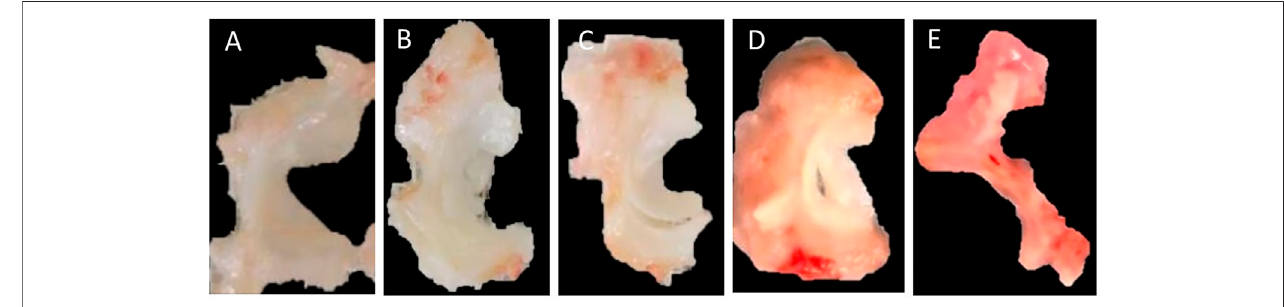
FIGURE 2 | Morphological scoring of the meniscus. (A) 0 = normal, (B) 1 = surface fi brillation, (C) 2 = undisplaced tears, (D) 3 = displaced tears, (E) 4 = tissue